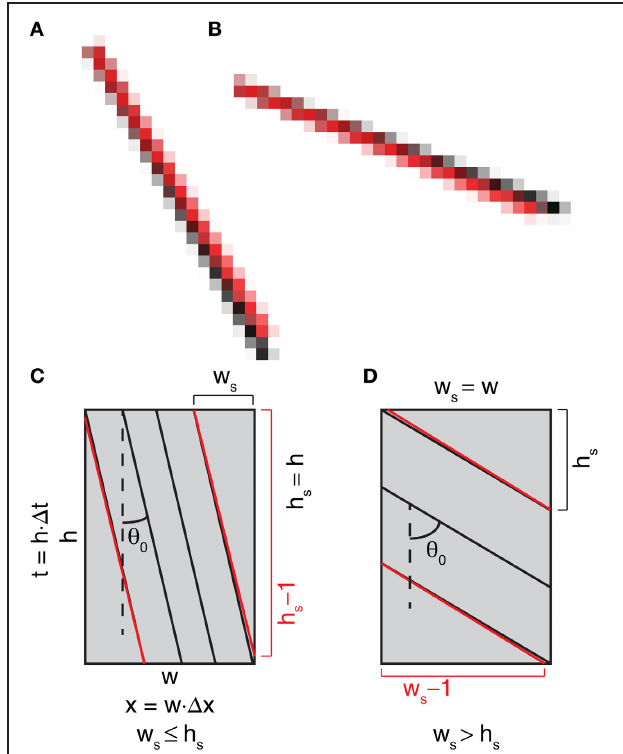
FIGURE 5 | Detection of the change in the RBC streak angle is constrained by the pixel resolution of the image. (A,B) Black and red stripes originating from the same pixel but terminating with 2-pixel offset vertically (A) or horizontally (B) . Noticeable separation of the stripes starts at the mid-point where the stripes are offset by 1 pixel. (C,D) Schematic diagram of a space-time image with stripes representing RBC streaks with relatively vertical ( | θ 0 | ≤ 45 ◦ , (C) or horizontal ( | θ 0 | > 45 ◦ , (D) streak angles. Red lines represent change in the RBC streak angle when the end of the streak is offset by 1 pixel in the longer dimension. Also see Materials and Methods for additional details on the detection sensitivity of the streak angle for an